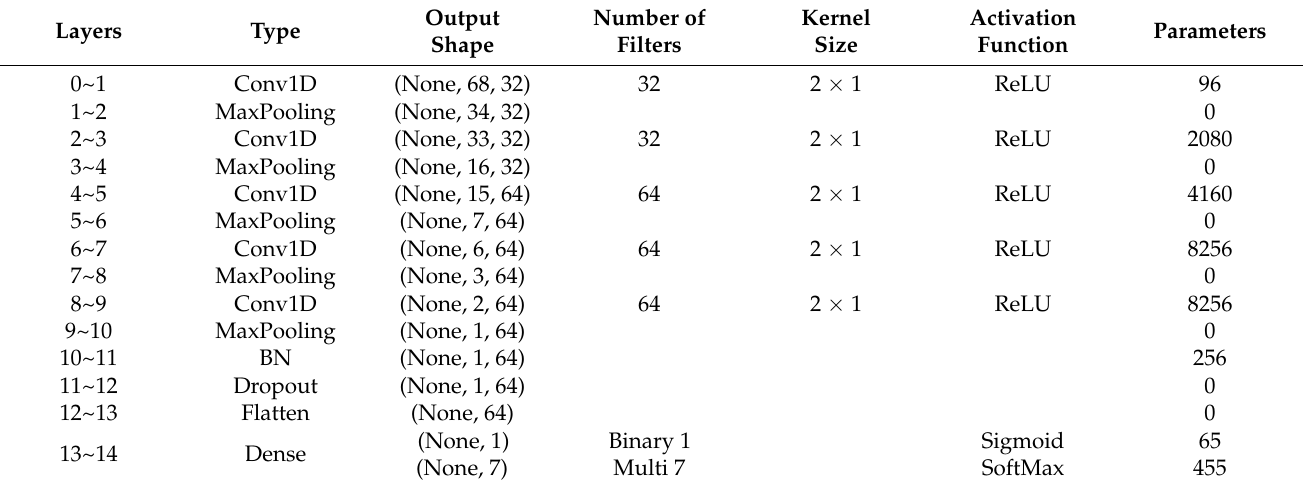
Table 9. CNN-5-256 (5 layers and 256